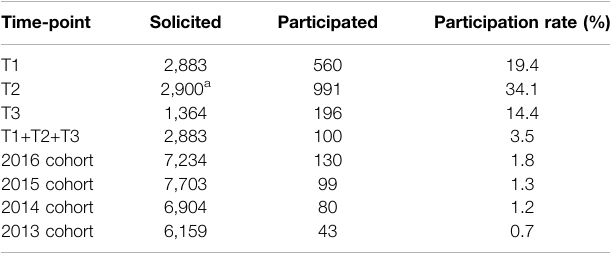
TABLE 1 | Current and previous participant recruitment and survey completion